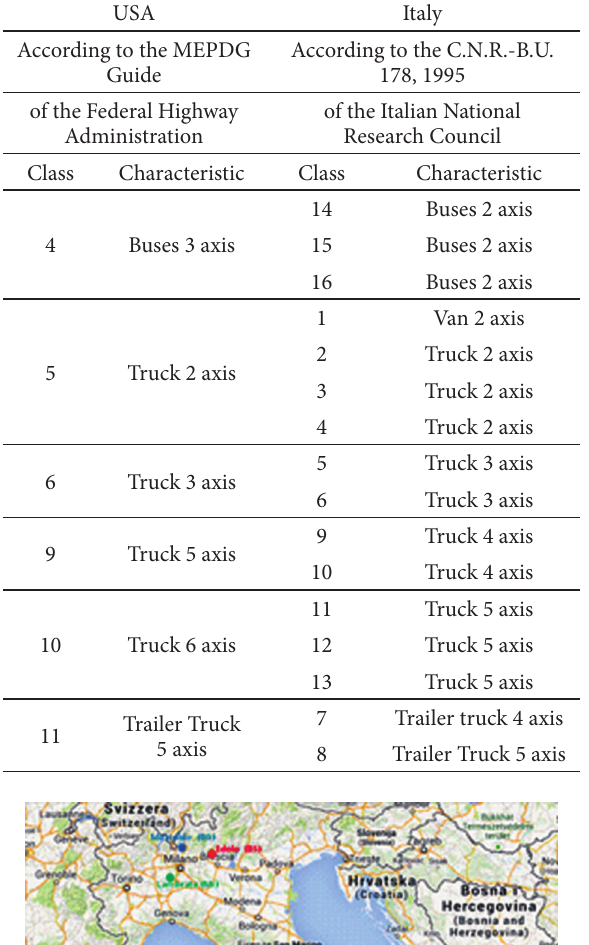
table 1. Equivalent classes in USA and Italy